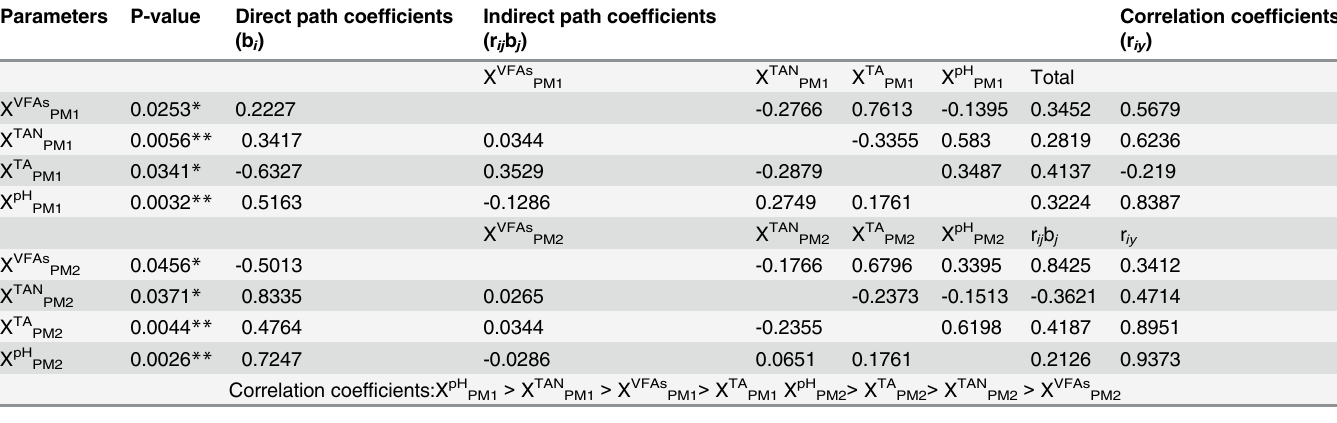
Table 2. Path analysis between VFAs, TAN, TA and pH and CBP of PM 1 and PM 2 . Parameters